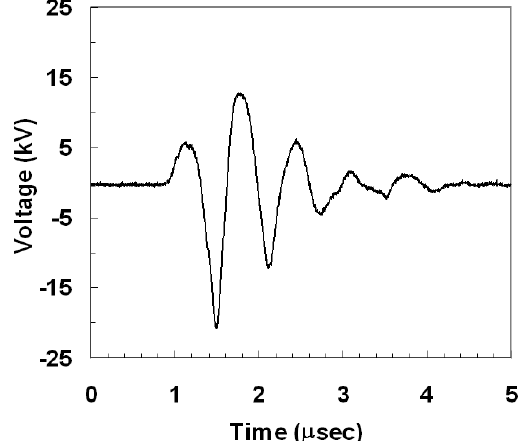
FIG. 6. (Color) (a) Time-energy phase space of 350 keV beam after passing through the energized PLIA. With the input voltage waveform of Fig. 5, an energy modulation of (cid:1) 80 to (cid:2) 150 keV was measured. (b) WARP3D simulation for similar conditions.